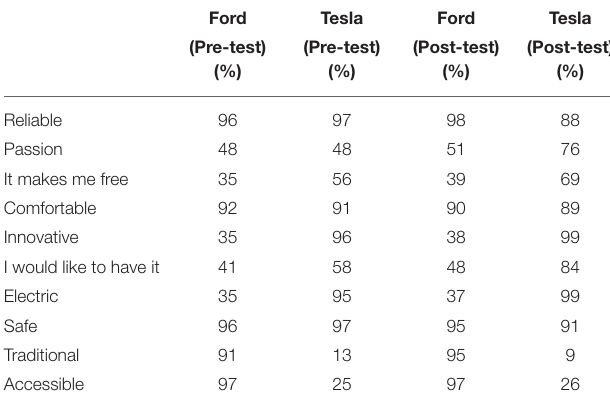
TABLE 2 | Frequency of Associations (FoA) expressed in percentage of the number of “yes” answers over the total sample (80 subjects exposed to the Tesla website).